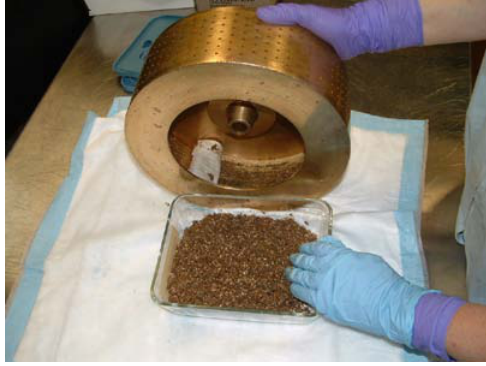
Figure 11. Basket rotor model 1357 with the insoluble marine tissue trapped by paper being removed and transferred into a borosilicate dish for freezing and